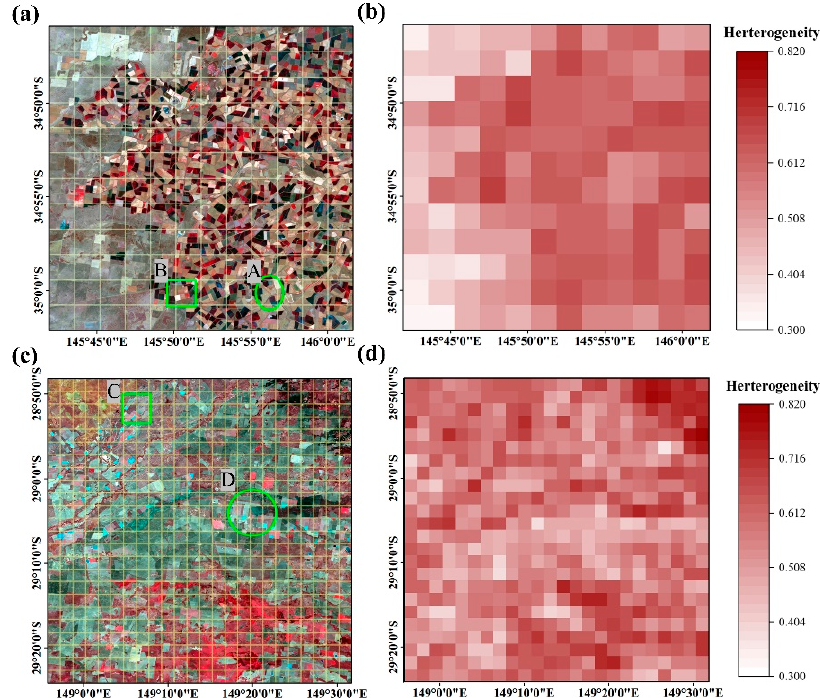
Figure 2. Examples of LHI maps. ( a ) Landsat color-infrared image (1200 × 1200 pixels) at Coleambally site acquired on 4 December 2001 divided into 12 × 12 blocks with each block containing 100 × 100 pixels; ( b ) the corresponding map of landscape heterogeneity index (LHI) calculated for each block. ( c ) Landsat color-infrared image (2400 × 2400 pixels) at Gwydir site acquired on 26 November 2004 divided into 24 × 24 blocks with each block containing 100 × 100 pixels; ( d ) the corresponding map of LHI calculated for each block. The time series prediction image of the sub region A, B, C and D in ( a , b ) will be presented in detail in Appendix A.